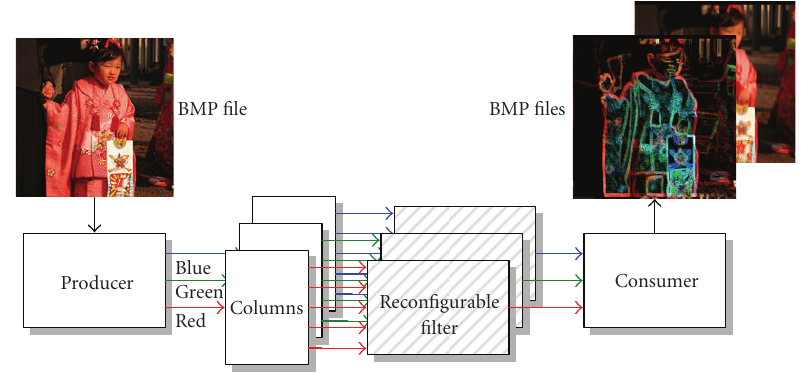
Figure 6: Video processing application.